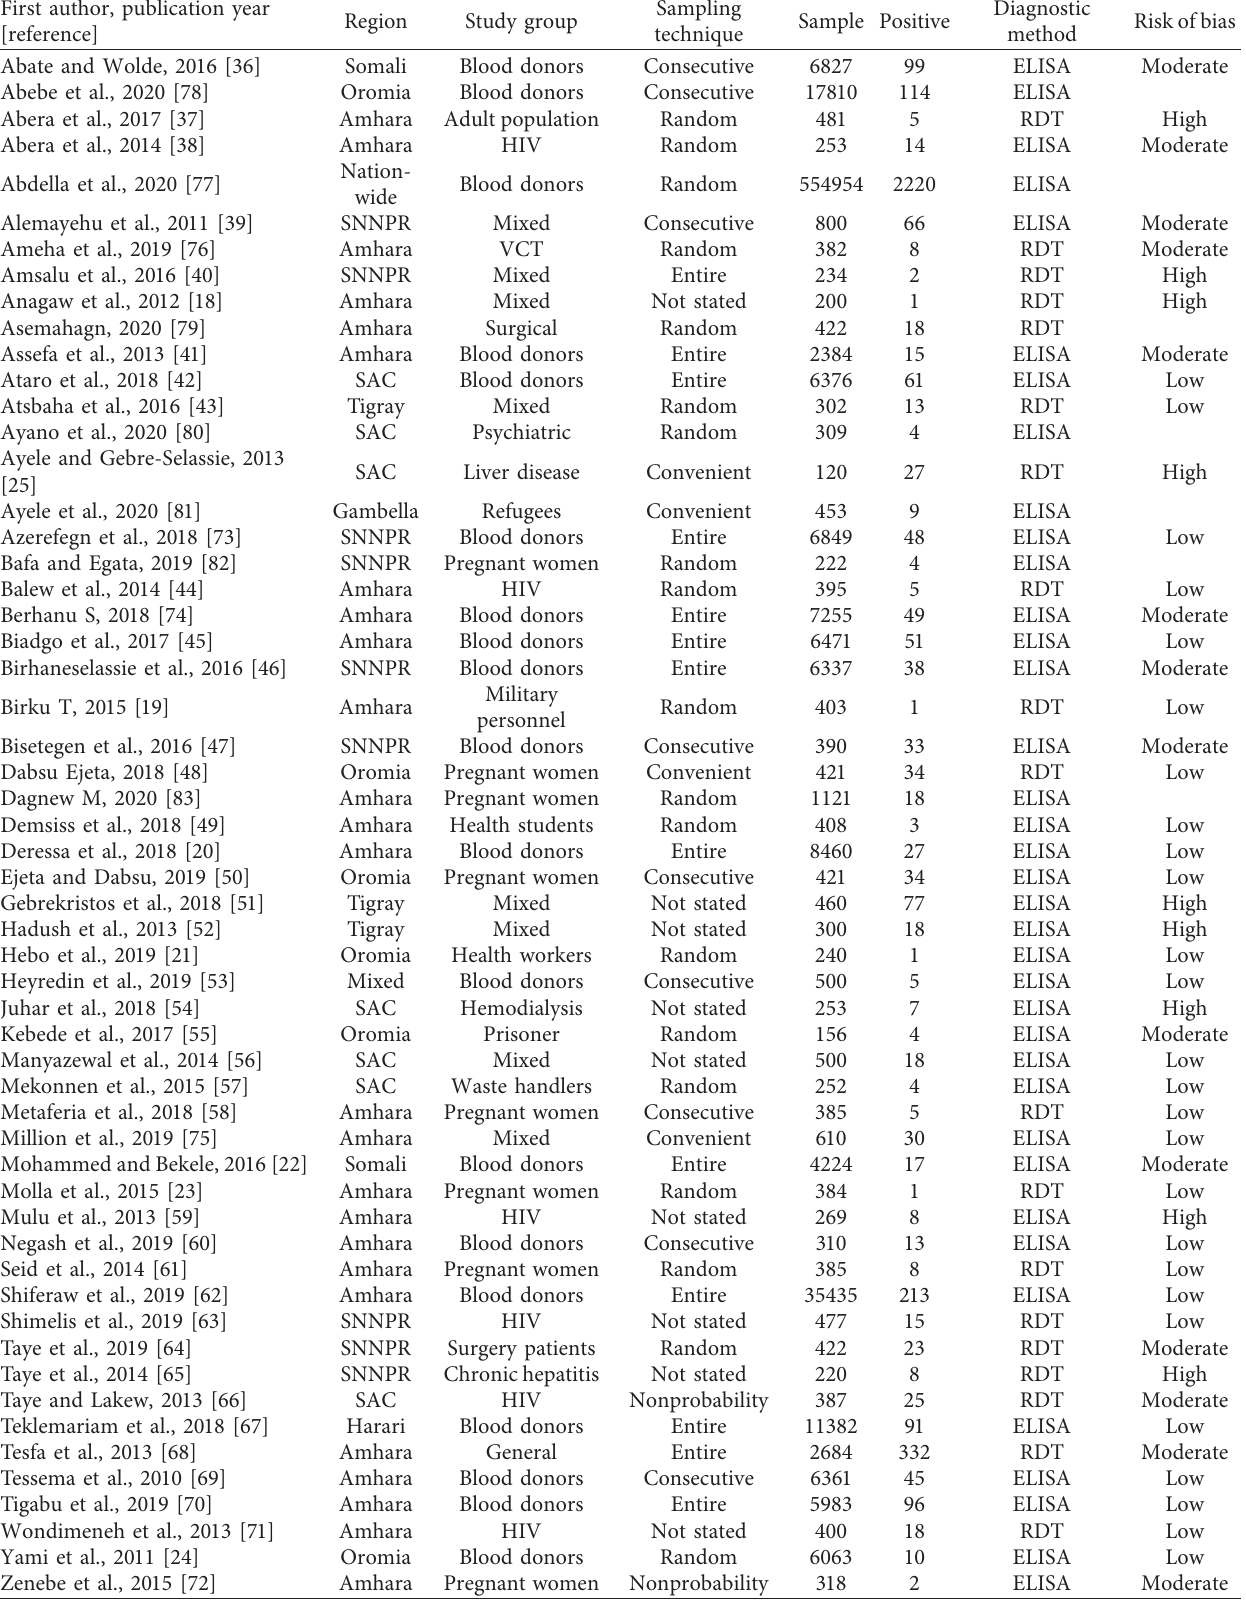
Table 1: Characteristics of the included studies in the systematic review and meta-analysis for the prevalence of anti-HCV in Ethiopia,